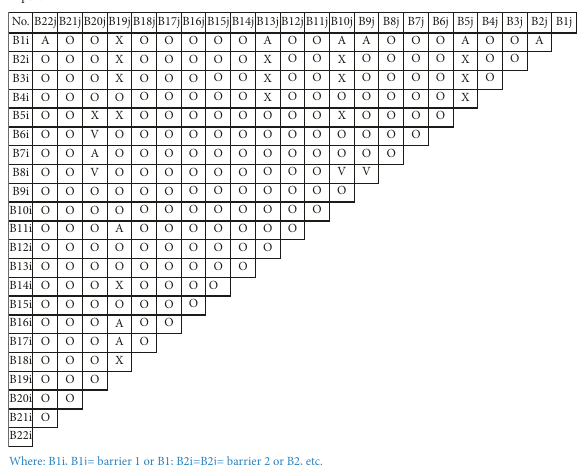
Table 6: ISSM from expert 3. etc.O Where: B1i, B1j= barrier 1 or B1; B2i=B2j= barrier 2 or B2,